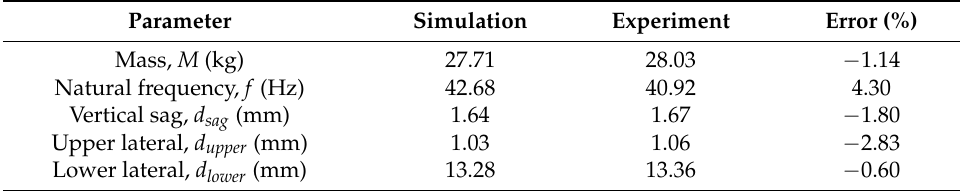
Table 2. Comparison of FE simulations and experimental